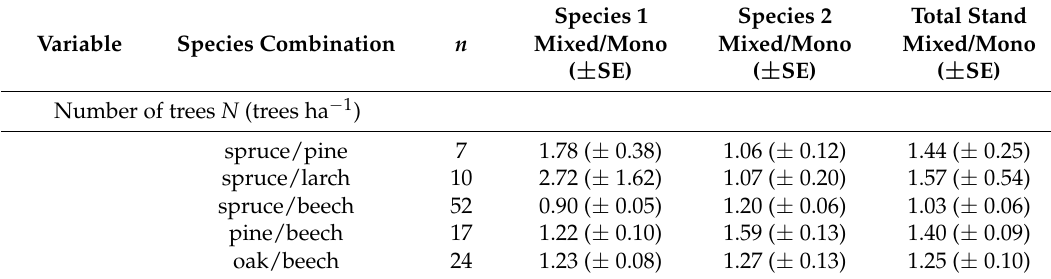
Table A1. Number of trees per ha ( N ) in mixed-species stands in relation to the neighboring monocultures calculated separately for five selected species assemblages (as resulting from evaluations in the context of [30] and kindly provided by the authors). Ratios mixed/mono above/below 1.00 indicate a superiority/inferiority of the species’ performance in mixed-species stands versus monocultures. Ratios in bold numbers indicate significant differences ( p < 0.05) between mixed-species stands and